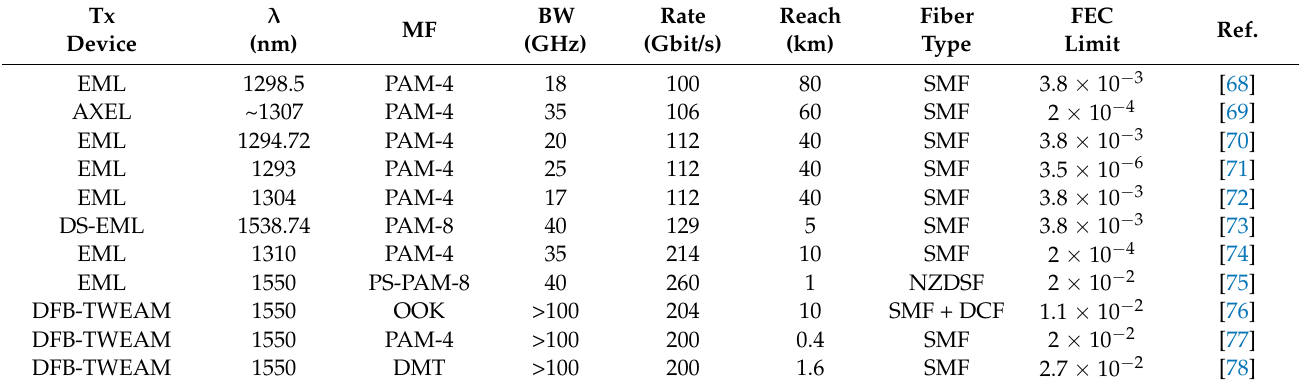
Figure 3. ( a ) Schema of DFB-TWEAM; ( b ) S 21 and S 11 characteristics of TWEAM; DFB: distributed feedback laser; TWEAM: traveling-wave electro-absorption modulators; QW: quantum wells; BCB: BenzoCycloButene layer; AC: alternating current; DC: direct current; (From [13], © 2009 IEEE). Table 4. Incomplete summary of EML applied in beyond 100-Gbit/s per lane data transmission .